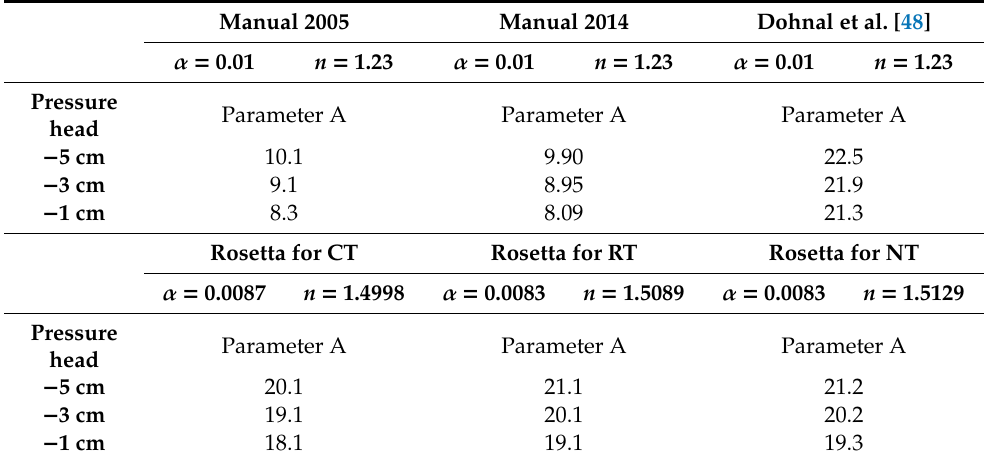
Table 1. Overview of α , n and A parameters used in Mini Disk infiltrometer (MDI) data